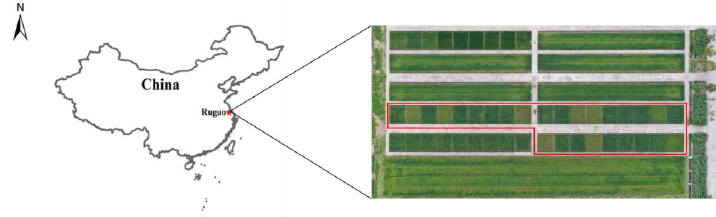
Figure 1. Wheat test scene, in which the red box is the wheat test plot.